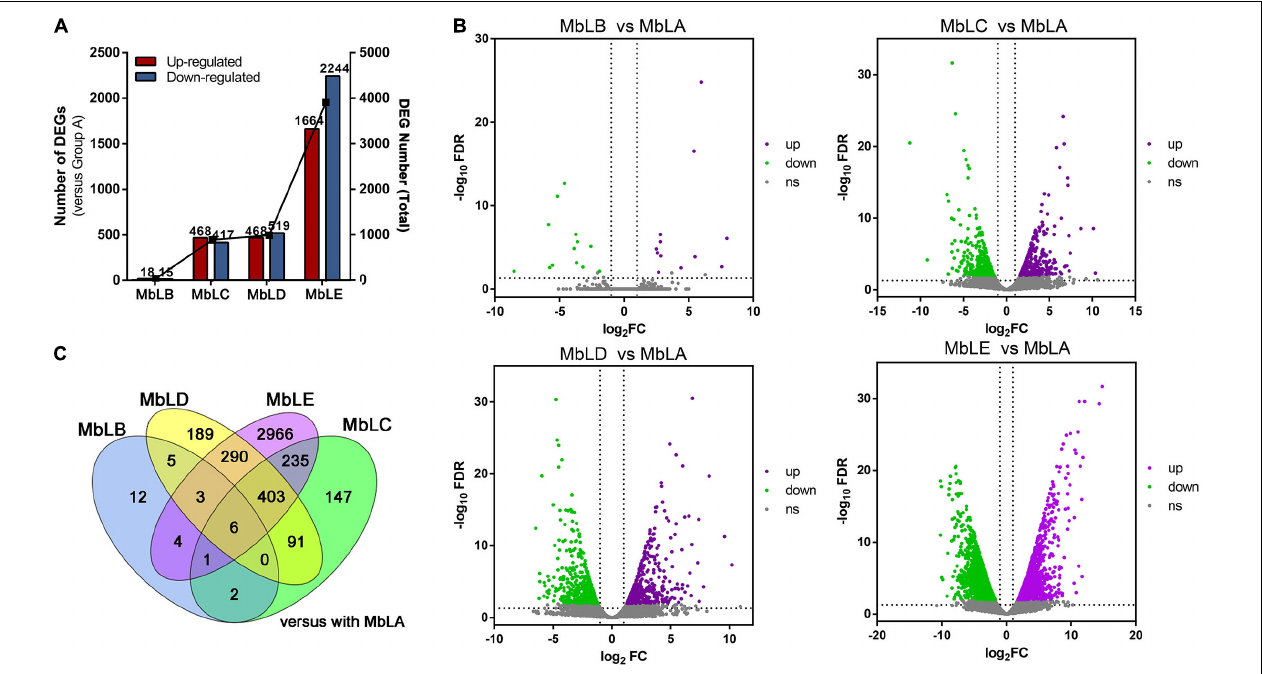
FIGURE 3 | Analysis of the differentially expressed genes (DEGs) at different periods. (A) The changes of upregulated DEGs and downregulated DEGs in different groups, with MbLA as control groups. (B) Volcano plots for DEGs in the MbLB vs. MbLA, MbLC vs. MbLA, MbLD vs. MbLA, and MbLE vs. MbLA groups. (C) Venn diagram for all DEGs in MbLB, MbLC, MbLD, and MbLE, with MbLA as the control